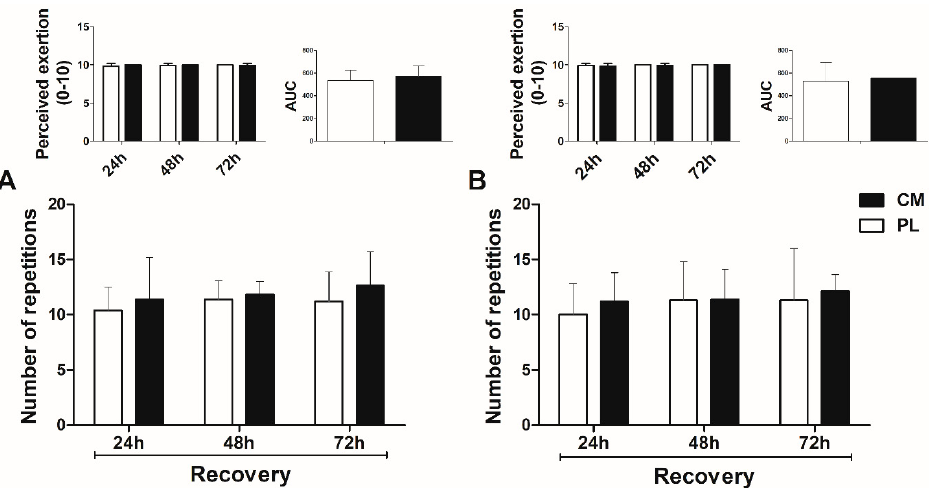
Figure 2. Number of maximum repetitions in the leg press ( A ) and hack squat ( B ) fatigue tests during recovery period at 24, 48, and 72 h post-exercise. Citrulline malate CM , Placebo PL . Left upper figure indicates the perceived exertion—OMNI scale (0–10) immediately after each test. Right upper figure indicates the area under curve (AUC) for 3-d recovery period. (repeated-measures ANOVA: time p > 0.05; treatment × time p > 0.05). Data are means ± SD.